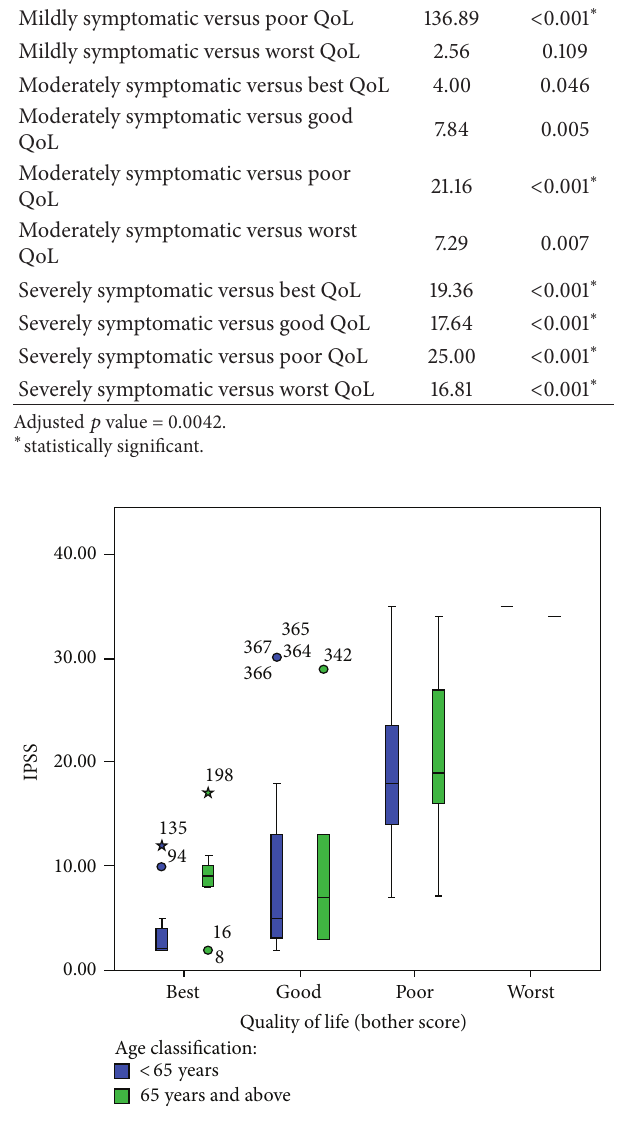
Figure 1: Showing quality of life versus age in